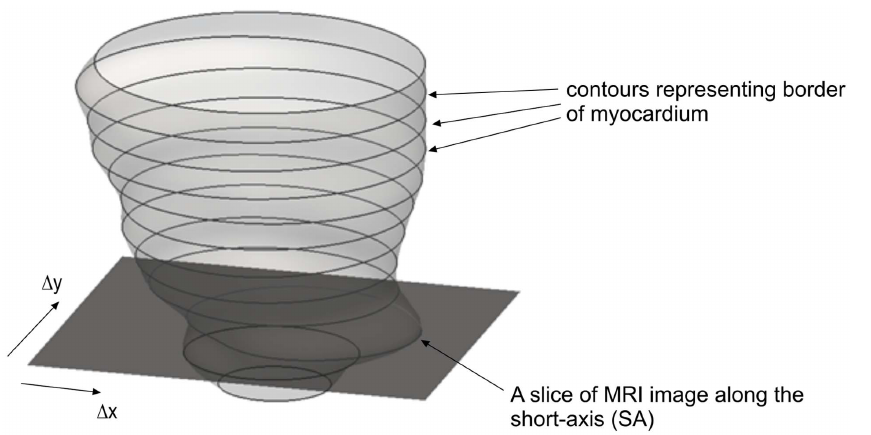
Figure 2. Shape Restoration of LV mesh in the x- and y-directions. Modifying shape of 3D LV epicardial surface mesh by translating the contours on SA slice in x- and y-directions.